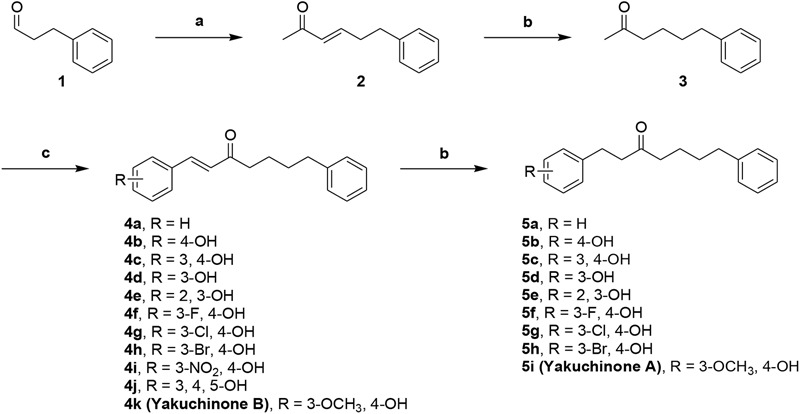
Synthetic route to compounds 4a–k and 5a–i. Reagents and conditions: (a) 1-(triphenylphosphoranylidene)propan-2-one, CH2Cl2, Δ, 79%; (b) 10% Pd-C, H2, EtOH, RT, 37-99%%; (c) benzaldehyde or substituted benzaldehyde, pyrrolidine, acetic acid, THF, Δ, 34–89%.